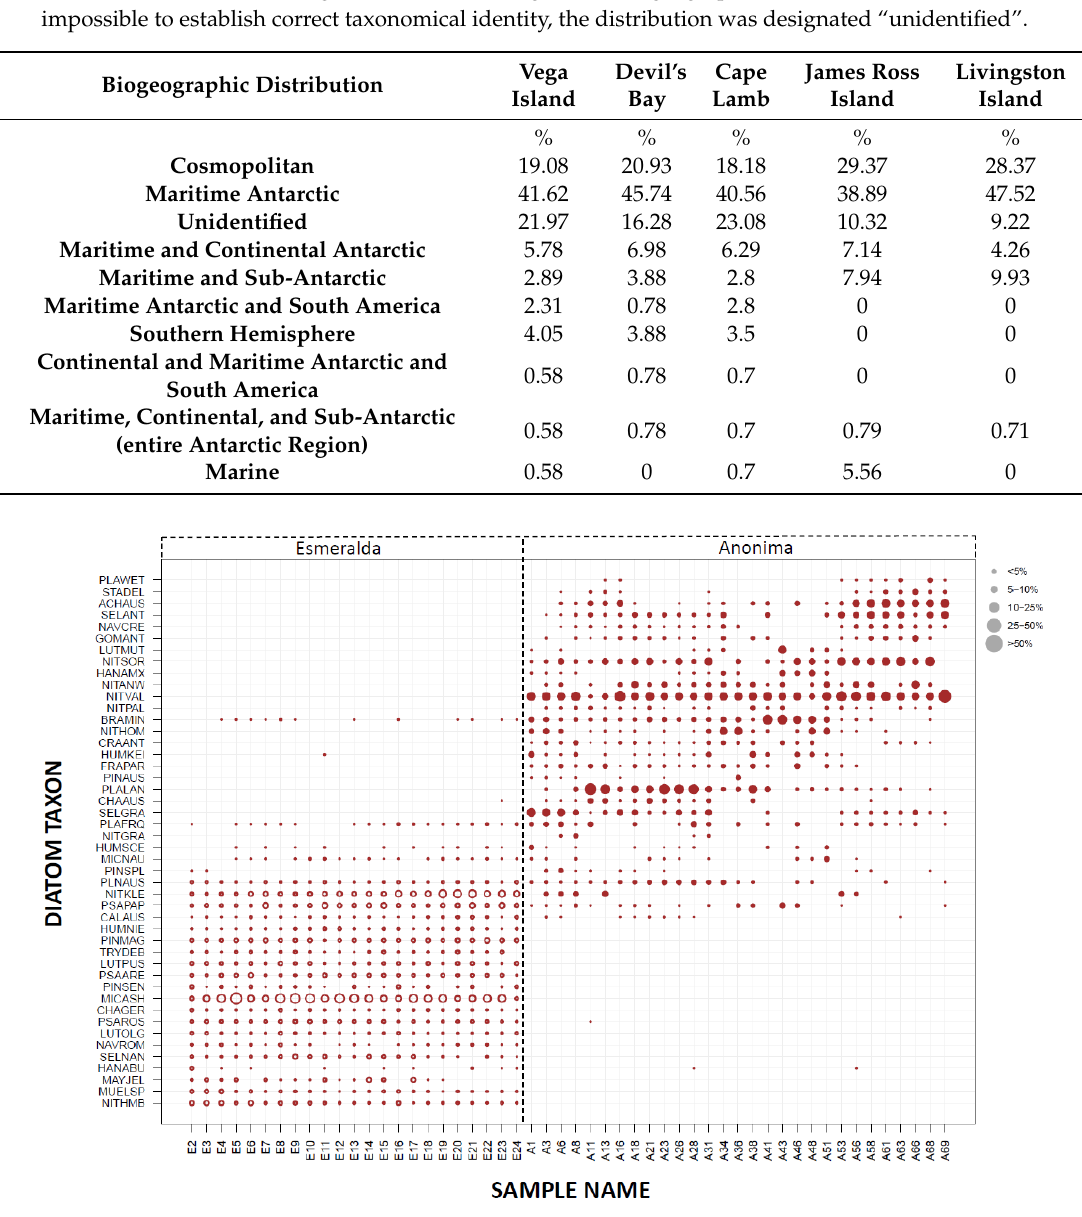
Figure 2. Dot plot representation of relative abundance counts. Sample codes are on the x-axis, and species names are on the y-axis. The size of a dot is proportional to the average relative abundance of a particular species in a given sample. Esmeralda core samples (Cape Lamb) are shown on the left side as un-filled brown circles, and Anónima core samples (Devil’s Bay) are shown on the right side as filled brown circles. Only diatoms with relative abundances > 4 % are plotted. The key for species abbreviations is shown in Table S2.